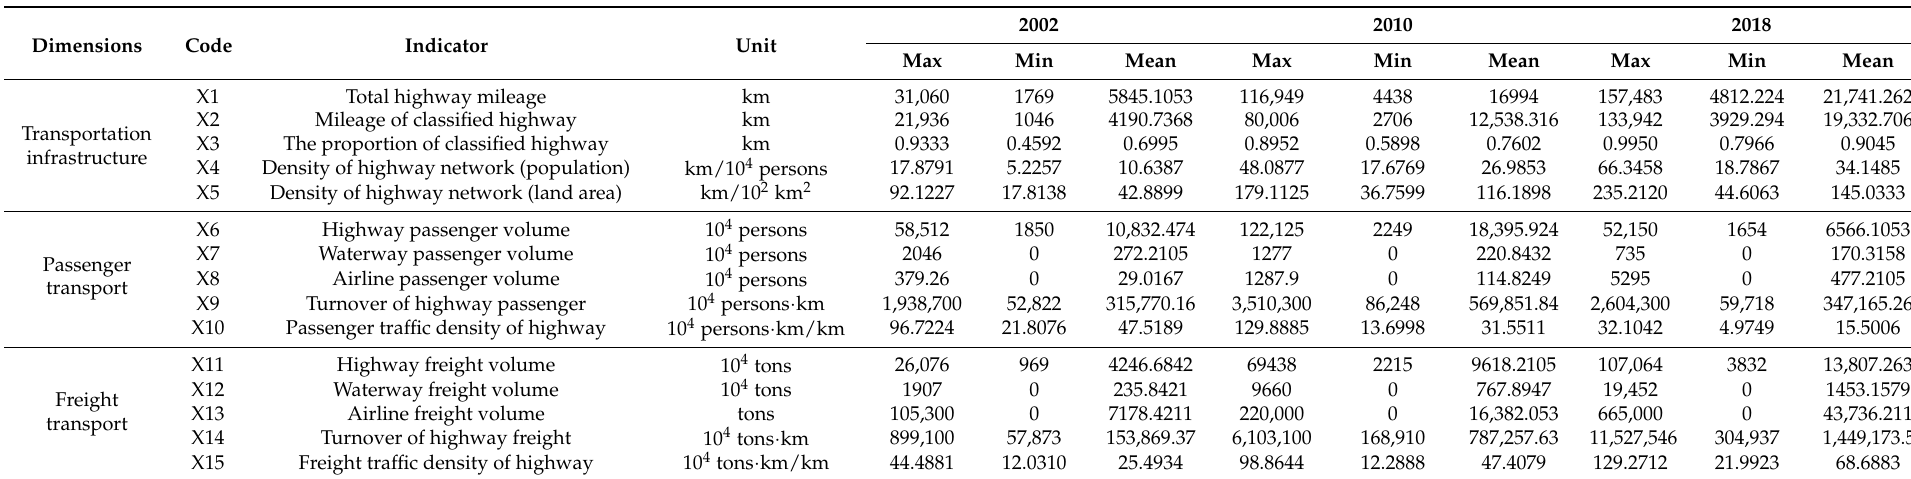
Table A1. Indicators of the field strength